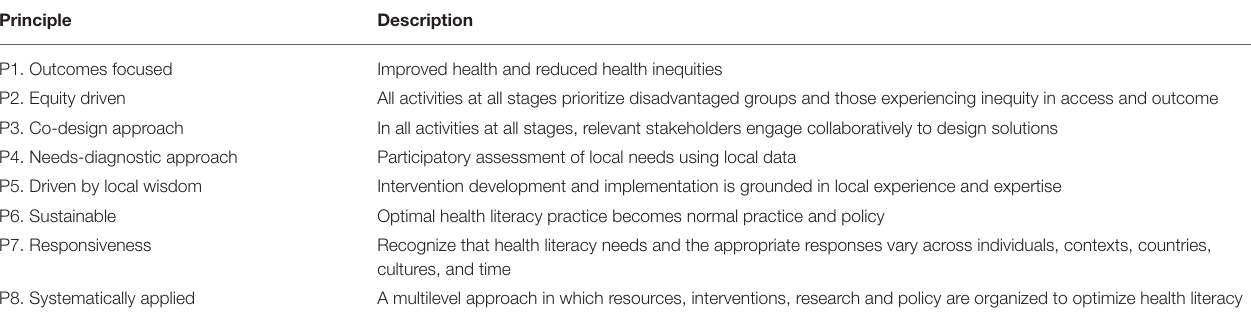
TABLE 1 | The 8 guiding principles of the Ophelia (Optimizing Health Literacy and Access) process * . Principle